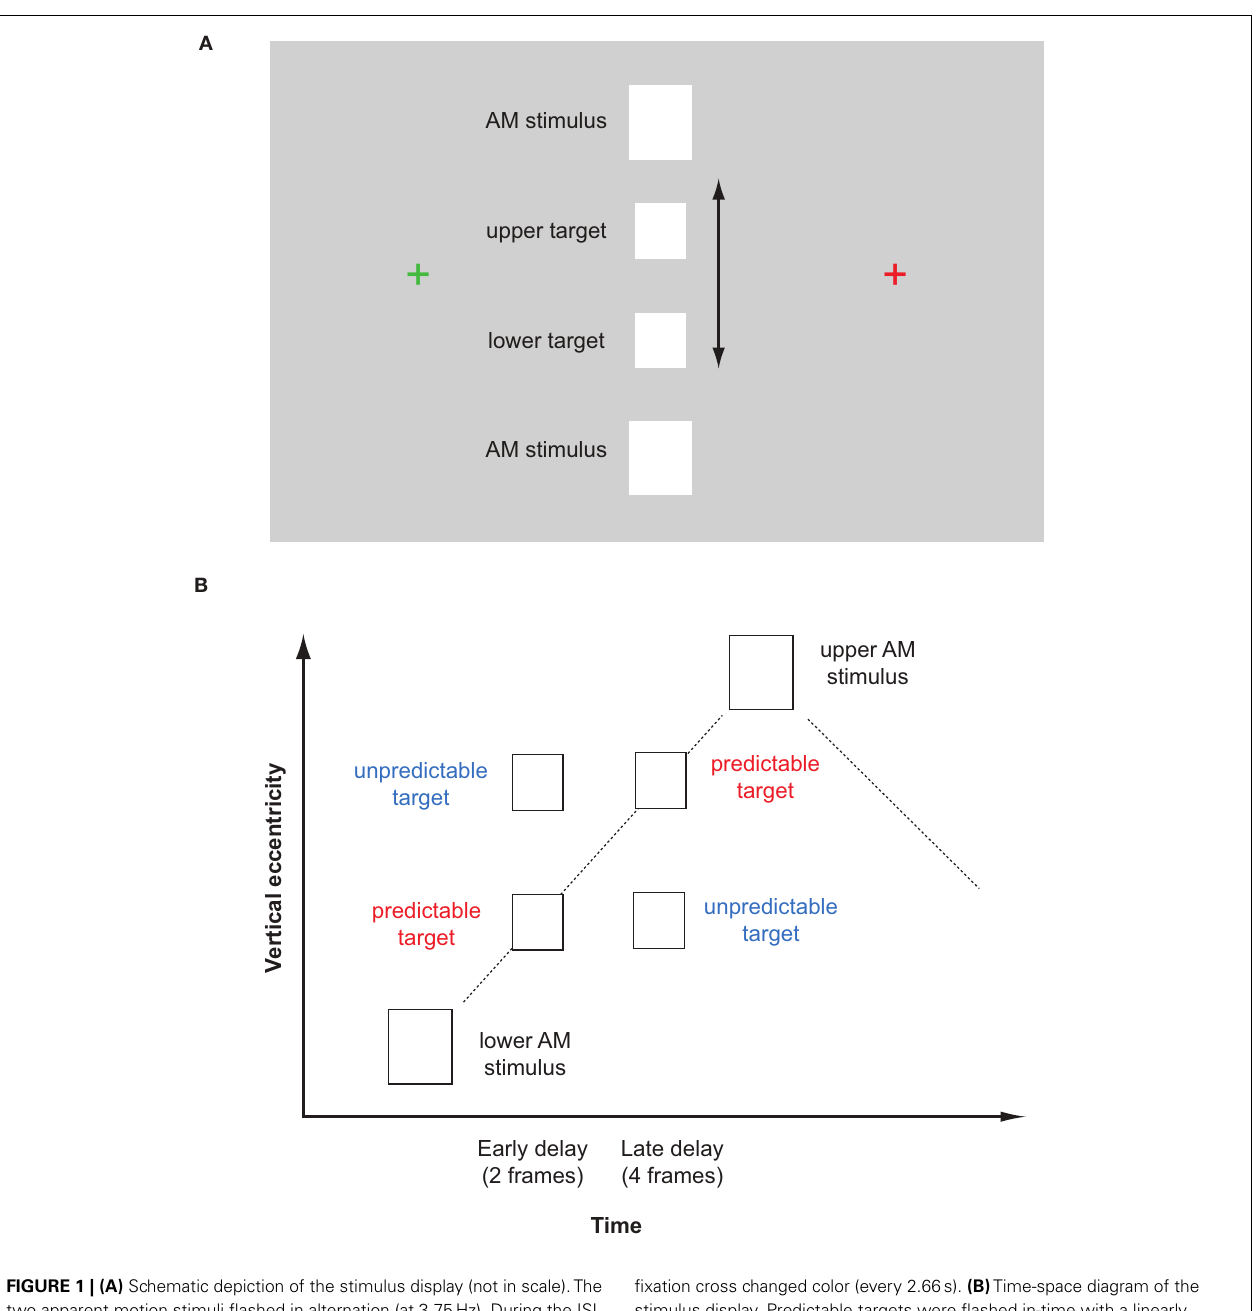
FIGURE 1 | (A) Schematic depiction of the stimulus display (not in scale).The two apparent motion stimuli flashed in alternation (at 3.75Hz). During the ISI, a target was flashed at either an upper or lower position on the apparent motion trace.The target was of the same shape and luminance as the apparent motion stimuli though slightly smaller. Subjects maintained their eyes at the red fixation cross and saccaded across the illusion when the